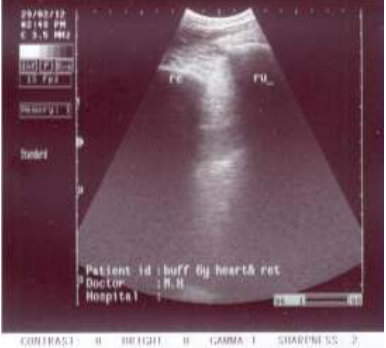
Figure-10. Lateral plain radiography of the cranial abdominal and caudal thoracic regions in 6-year- old buffalo showing radio-opaque metallic foreign body- long needle (1) and loss of details due to filling the pericardial sac with exudates. The case was diagnosed as traumatic pericarditis.